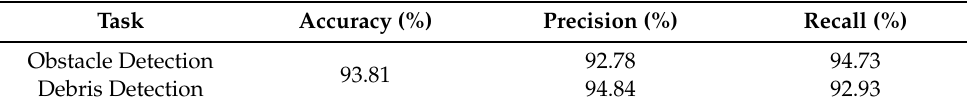
Table 3. Statistical analysis for obstacle and debris detection.